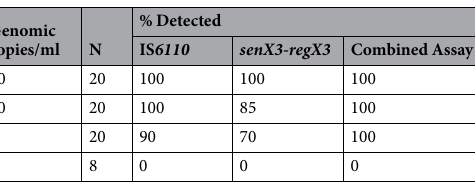
Table 1. Limit of detection of IS 6110 , senX3-regX3 and combined qPCR assays in the XtracTB